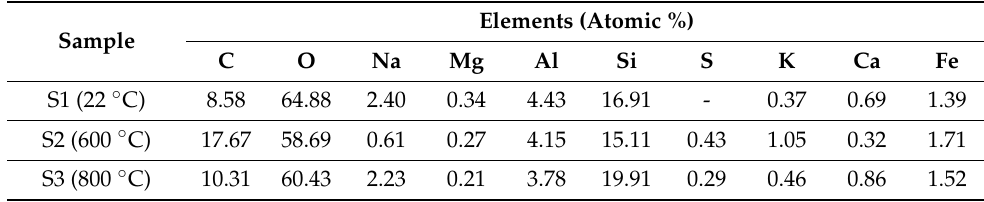
Table 1. Elements (atomic %) present in the samples S1 (22 ◦ C), S2 (600 ◦ C), and S3 (800 ◦